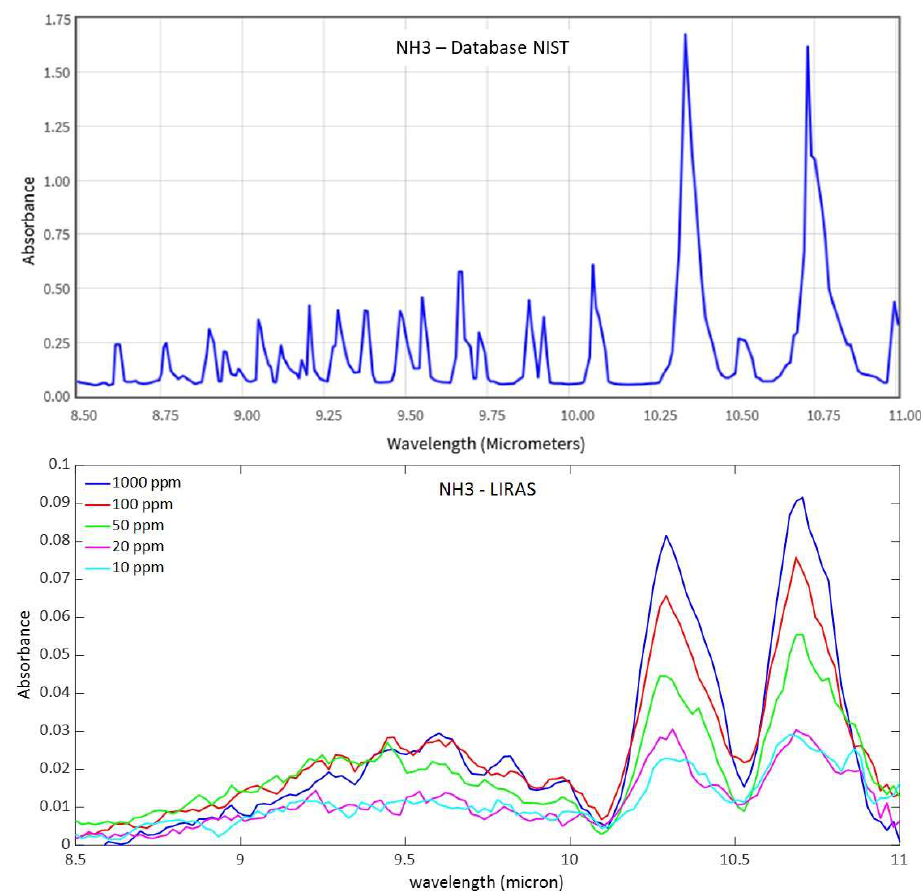
Figure 10. Comparison between the reference spectrum of ammonia from the NIST database (at 4 cm − 1 resolution) and spectra acquired at different concentrations of ammonia by the LIRAS sensor (at a lower resolution).